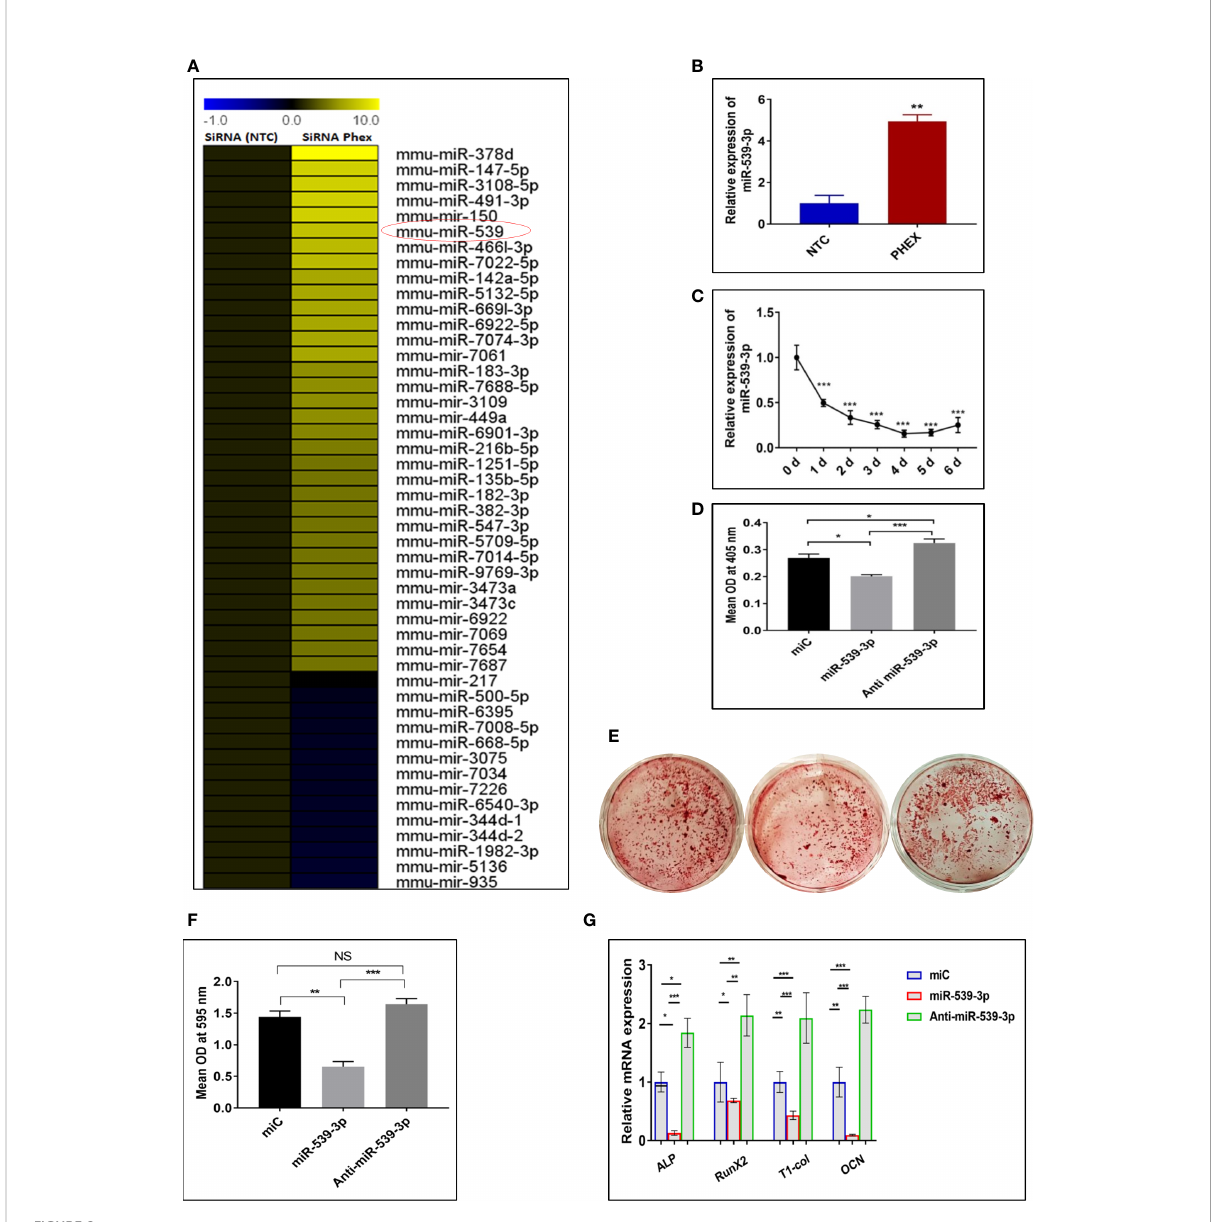
FIGURE 2 miRNAs expression pro fi les during phex -silenced osteoblast differentiation. (A) miRNAs sequencing pro fi ling. Only representative miRNAs that were notably downregulated and upregulated are given, with yellow denoting high expression and blue indicating low expression respect to the median (n=2). (B) miR-539-3p expression in siPHEX osteoblast cells after 48 h of transfection. Data are expressed as mean ± SEM (n=6), **P < 0.01 compared NTC group. (C) Changes in miR-539-3p expression during osteoblast differentiation with the time. (D) Mouse calvarial osteoblasts (MCOs) were treated with negative control (miC), miR-539-3p and anti-miR-539-3p in osteoblast differentiation medium and ALP activity was measured after 48 h. (E) Murine osteoblasts were seeded in 6-well plates and cultured for 14 days followed by alizarin red S staining. Representative photomicrograph show mineral nodule formation in different groups. (F) Quanti fi cation of alizarin red S staining at 595 nm. (G) qRT-PCR evaluation osteogenic marker genes (ALP, RUNX-2, Type-1-collagen, OCN normalized to GAPDH) at 48 h. Data are expressed as mean ± SEM (n=6) *P < 0.05, **P < 0.01, ***P < 0.001 and NS, non-signi fi cant compared in between